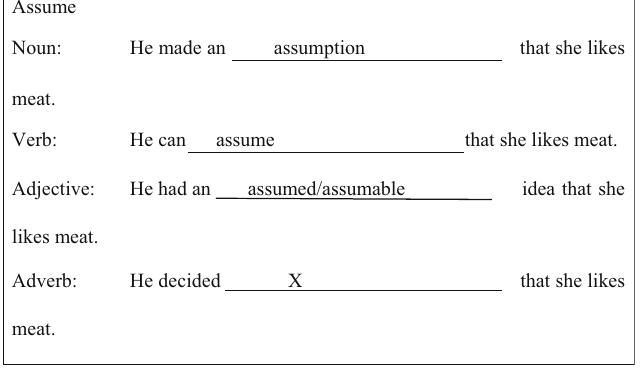
Figure 1: An example of the test items of